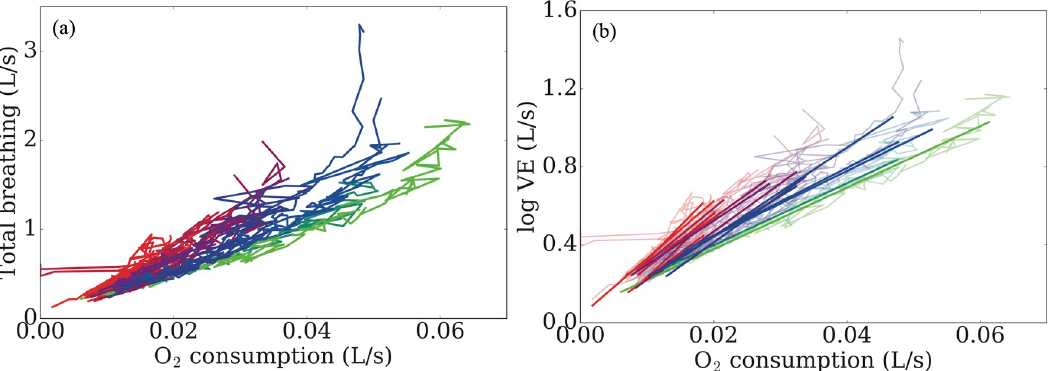
Fig 5. (a) Total ventilation plotted against oxygen utilisation. We observe that breathing pattern is strongly correlated with test performance. (b) Exponential curves are fitted through the raw data, further highlighting this dependence.